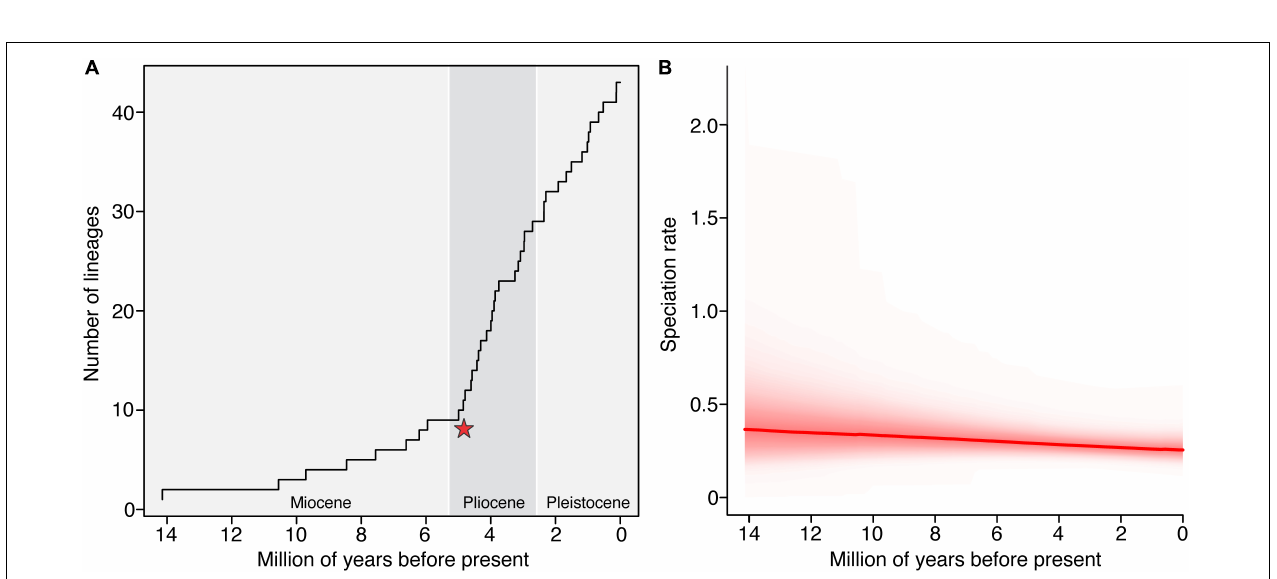
FIGURE 2 | The most probable biogeographical scenario for Neotropical Sciurini based on the set of ancestral ranges that received the highest likelihood in the Neotropical scale analysis, as inferred by BAYAREALIKE + J model. Colors in key boxes and map correspond to coloring of internal tree nodes (most probable ancestral ranges) and terminal taxa (current distribution of species). Strait arrows denote anagenetic dispersal events and curved arrows designate founder-event speciation (jump).